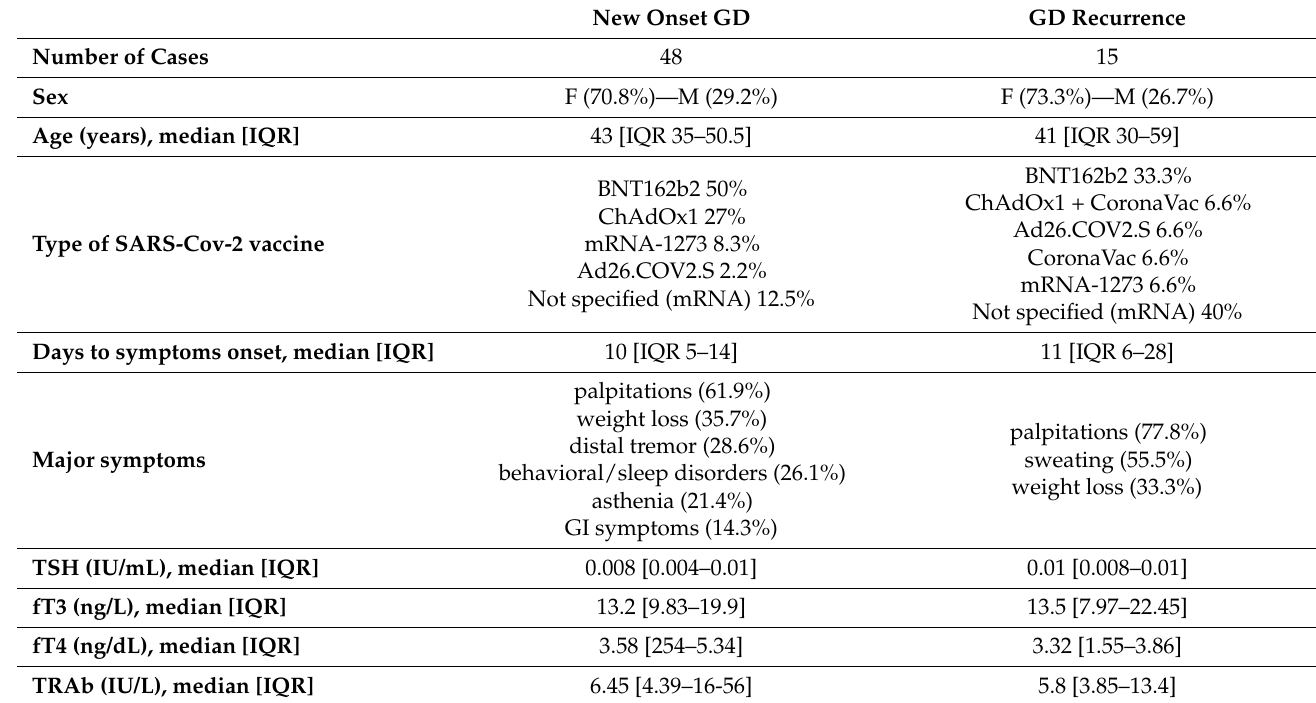
Table 3. Overview of new cases and relapses of Graves’ disease following SARS-CoV-2 vaccination reported in the